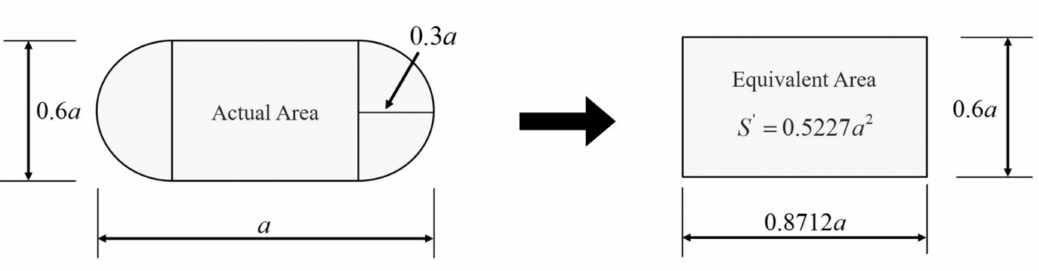
Figure 3. The equivalent contact area of truck